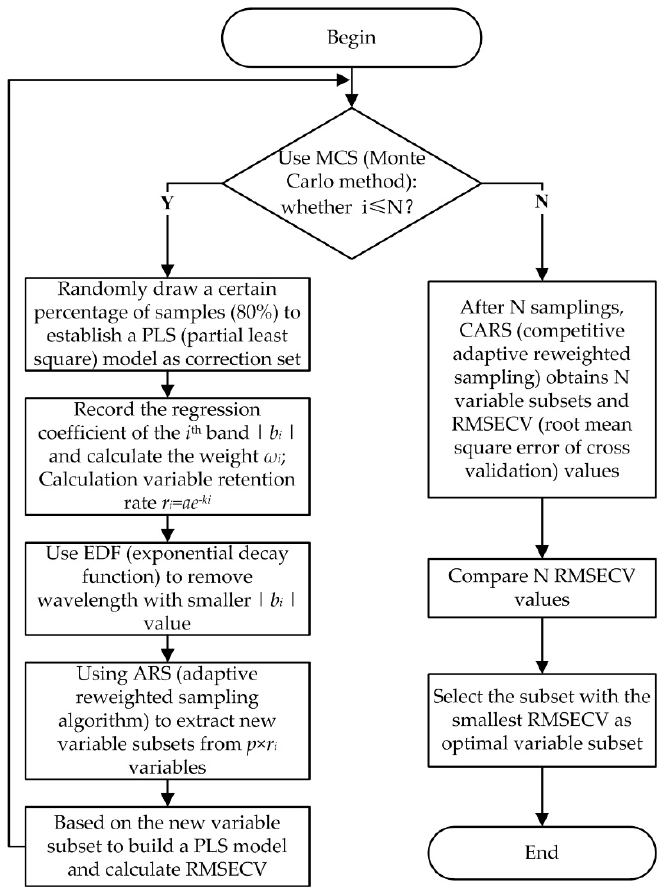
Figure 3. Flow chart of the CARS (competitive adaptive reweighted sampling) algorithm.